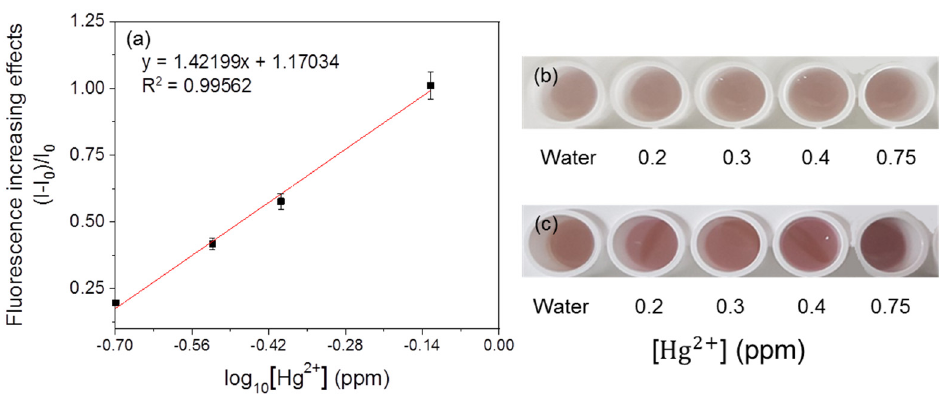
Figure 11. Concentration-dependent responses of the immobilized fluorescent mercury-sensing strain with mercury. ( a ) The correlation between fluorescence increasing effects and mercury concentration of the strain. Visual detection of responses ( b ) before responses, ( c ) after 17 h, and ( d ) 19 h.